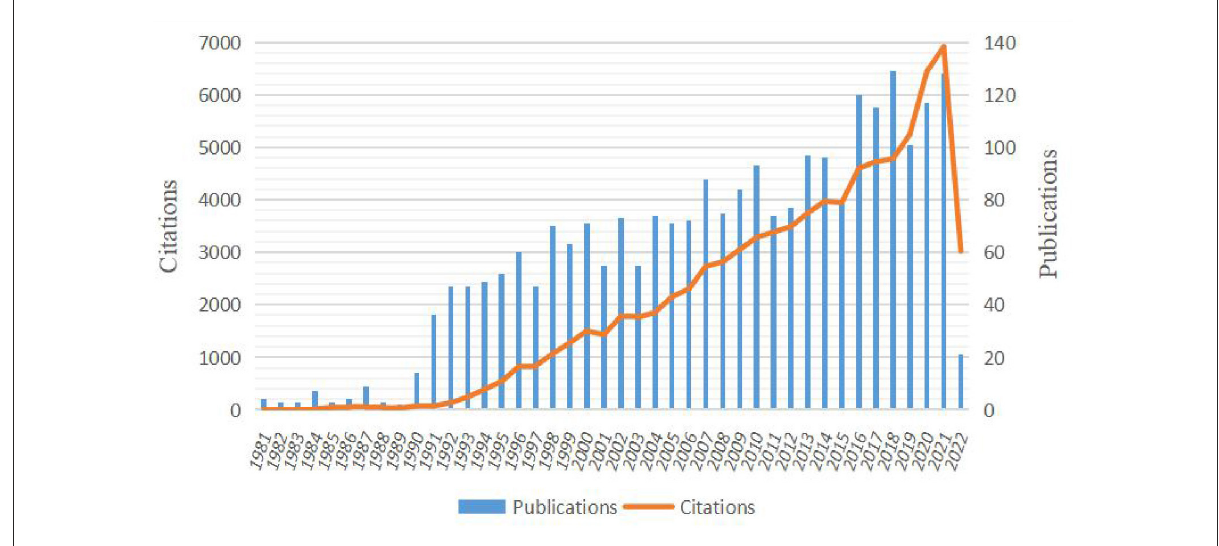
FIGURE1 Times cited and publications over time from total documents.